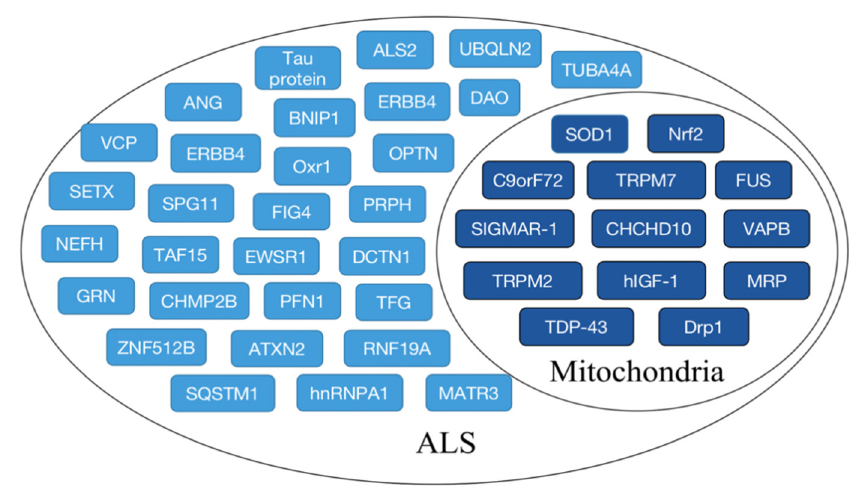
Figure 3. ALS-related biomarkers. The main biomarkers associated with ALS are shown, and biomarkers associated with mitochondrial dysfunction in ALS are indicated by dark blue boxes. Table 2. Genetic markers associated with mitochondrial dysfunction in